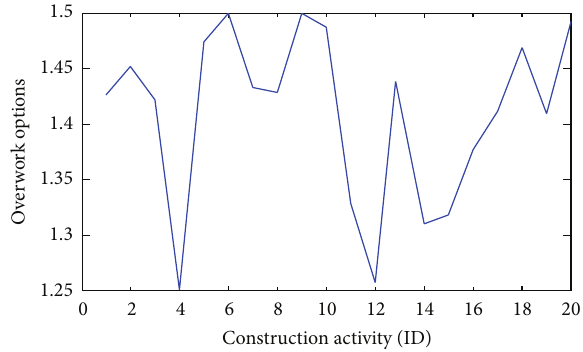
Figure 4: Optimized working hours a day in twenty activities.